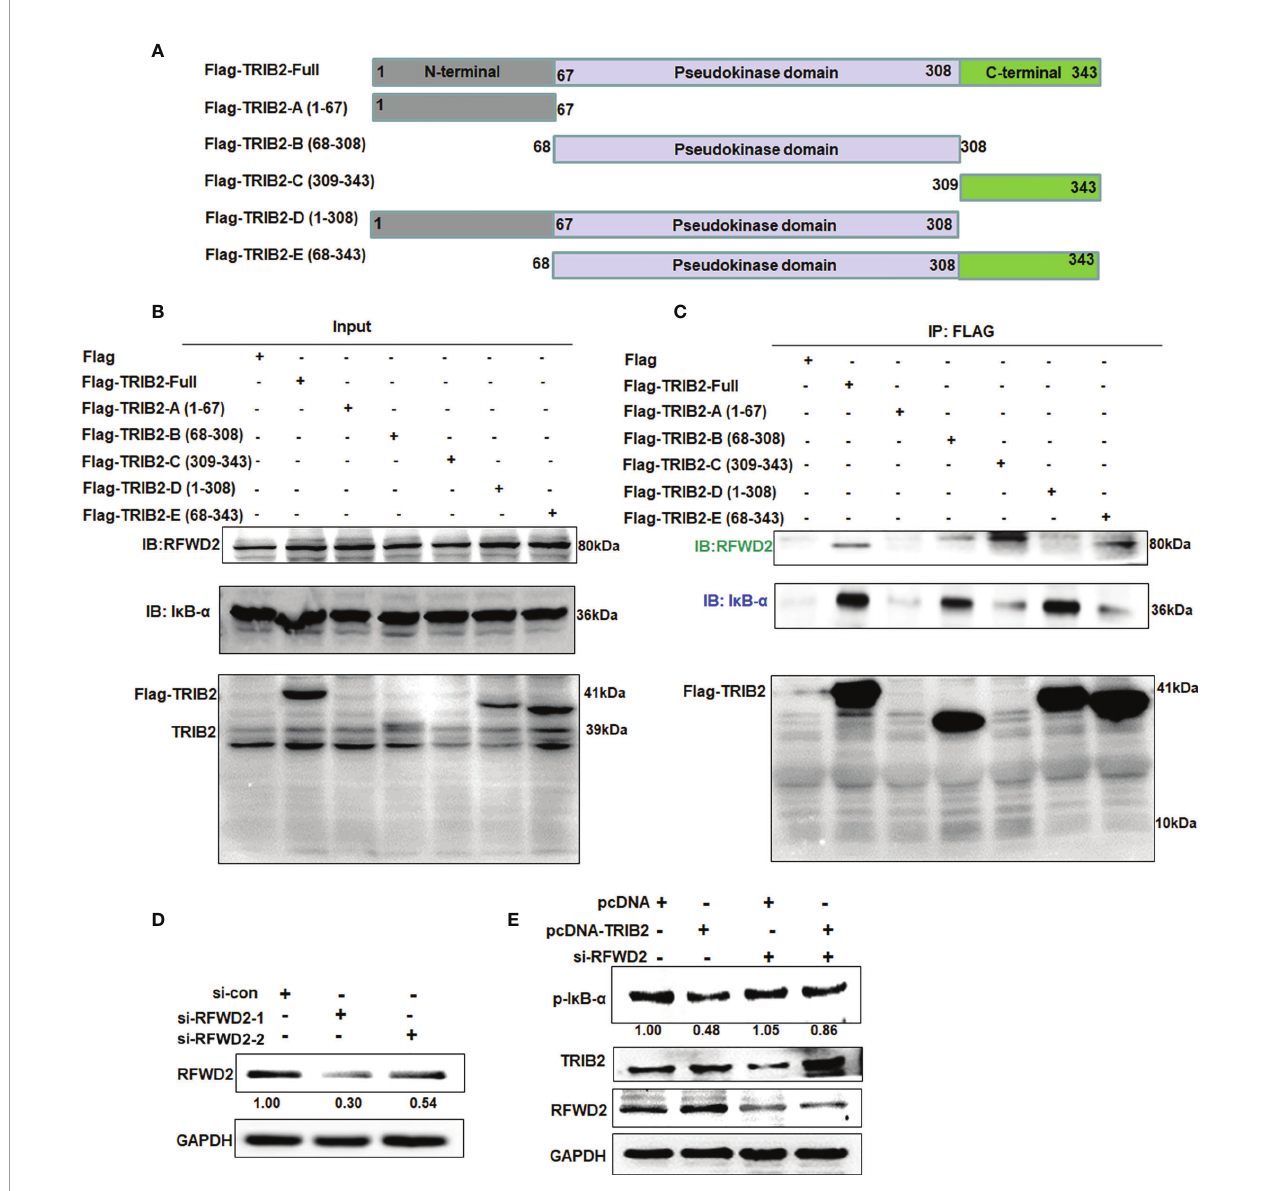
FIGURE 5 | Mapping interaction of TRIB2 with I k B- a or RFWD2. (A) Diagram showing constructs of Flag-TRIB2 and its deletion mutants. (B, C) Coimmunoprecipitation analysis of the domains of TRIB2 involved in the interaction with RFWD2 and I k B- a in 293T cells treated with Flag-TRIB2 deletion mutants. (D) Expression levels of RFWD2 were decreased in RFWD2-siRNA-treated A549 according to Western blotting. RFWD2 expression was normalized to GAPDH. (E) RFWD2 knockdown attenuated the role of TRIB2 in regulating the expression of p-I k B- a , as shown by Western blotting. Relative intensities of p-I k B- a were normalized to that of